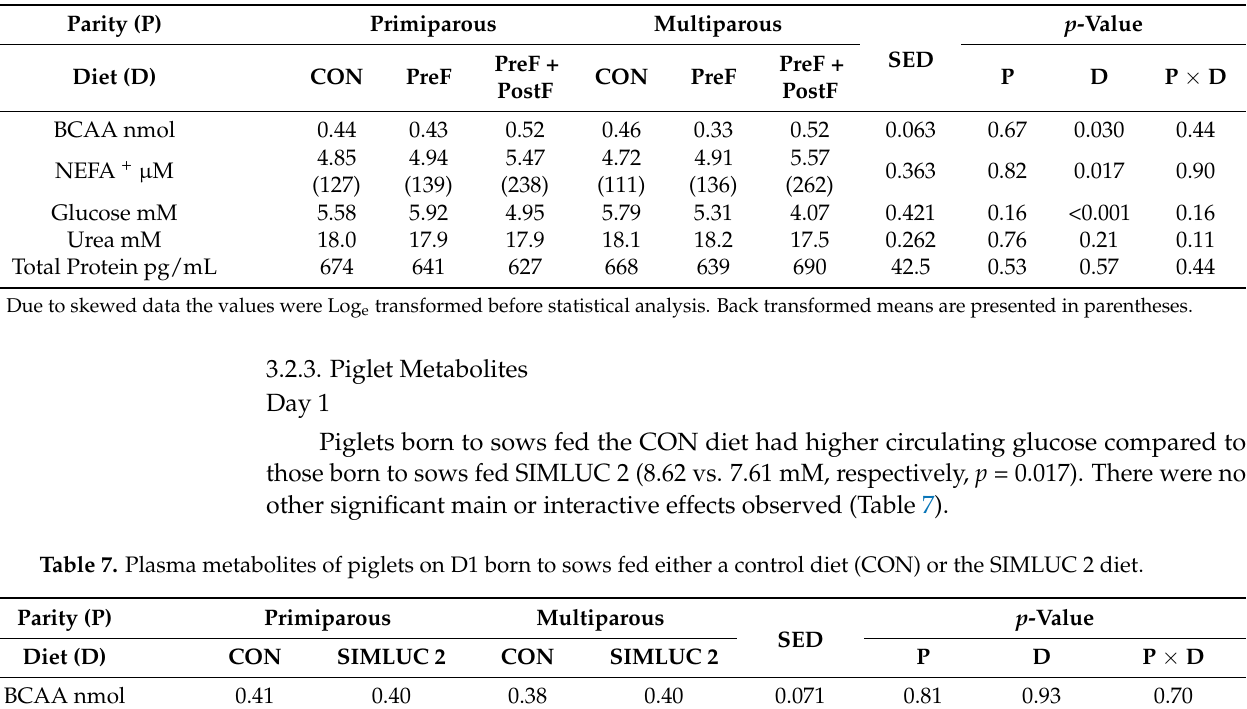
Table 6. Plasma metabolites of primiparous and multiparous sows on D10 fed either a control (CON) diet or SIMLUC 2 diet fed pre-farrowing (PreF) or fed both pre-farrowing and 10 days post-farrowing (PreF + PostF). Parity (P) Primiparous Diet (D) BCAA nmol